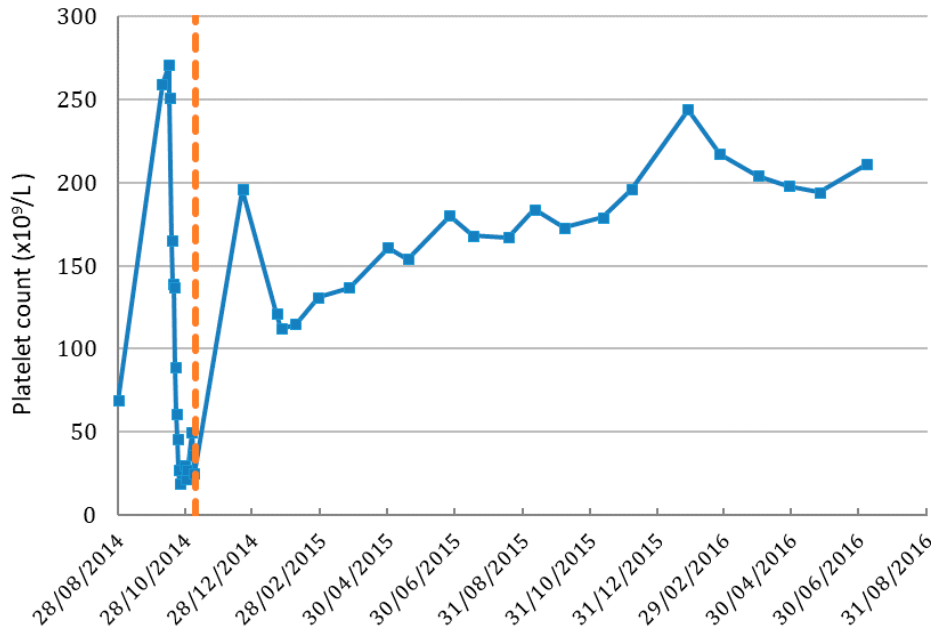
Figure 1. Platelet cell count in patient before and after IV vitamin C treatment. Dashed line indicates the IV vitamin C commenced date. Normal range of platelet count is 150–400 ( × 10 9 /L).